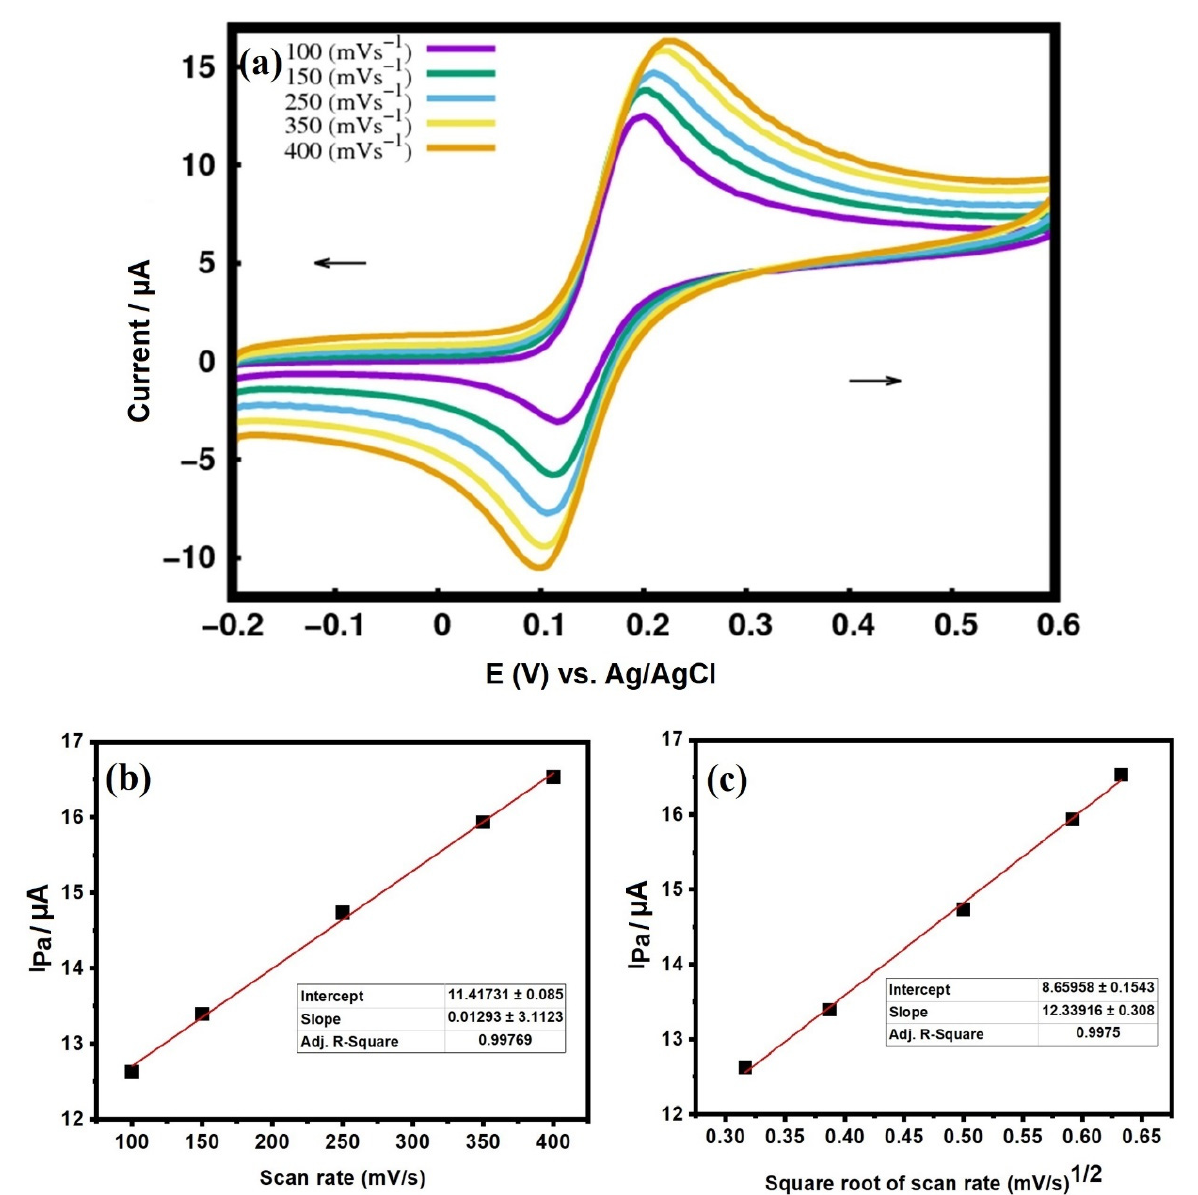
Figure 10. ( a ) The cyclic voltammogram at 6 mg CMCPE at 2 mM dopamine concentration in a phosphate buffer solution (PBS) of pH 7.2. ( b ) Plot of anodic peak current vs. scan rate ( c ) Plot of anodic peak current vs. square root of scan rate.